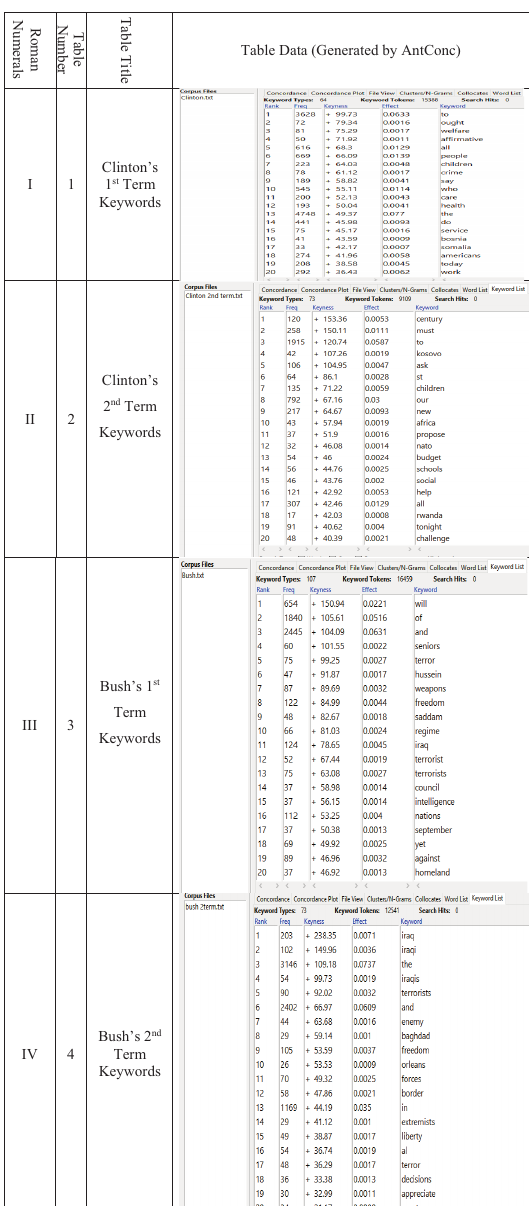
Table Data (Generated by